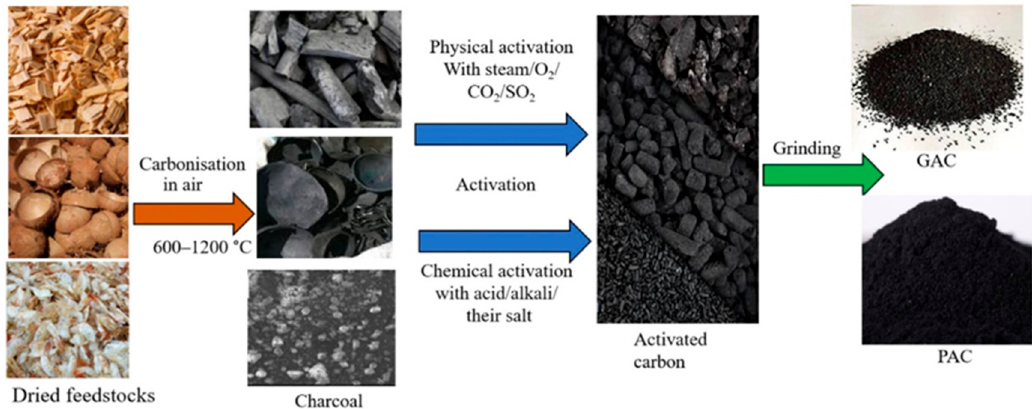
Figure 7. Production procedure of activated carbons from different types of biomasses [80] (reprinted with copyright